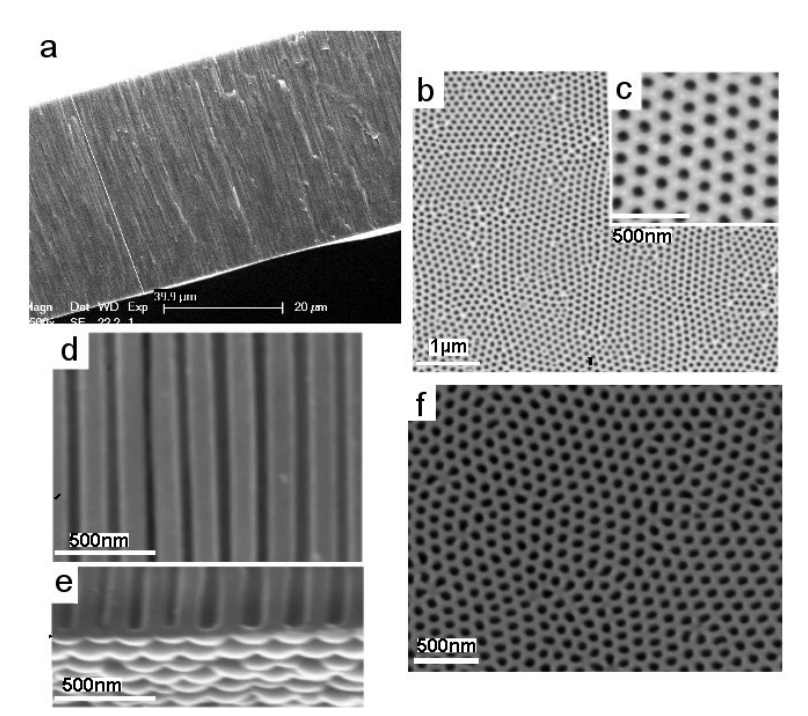
Figure 2. SEM images of PA membranes prepared by electrochemical anodisation of Al foil showing. (a) Cross-section of whole membrane structure; (b-c) top surface of pores; (d) high-resolution cross-sectional image of PA membranes showing straight channel of pore structures; (e) bottom surface with closed pores before pore opening; and (f) the bottom pore surface after pore